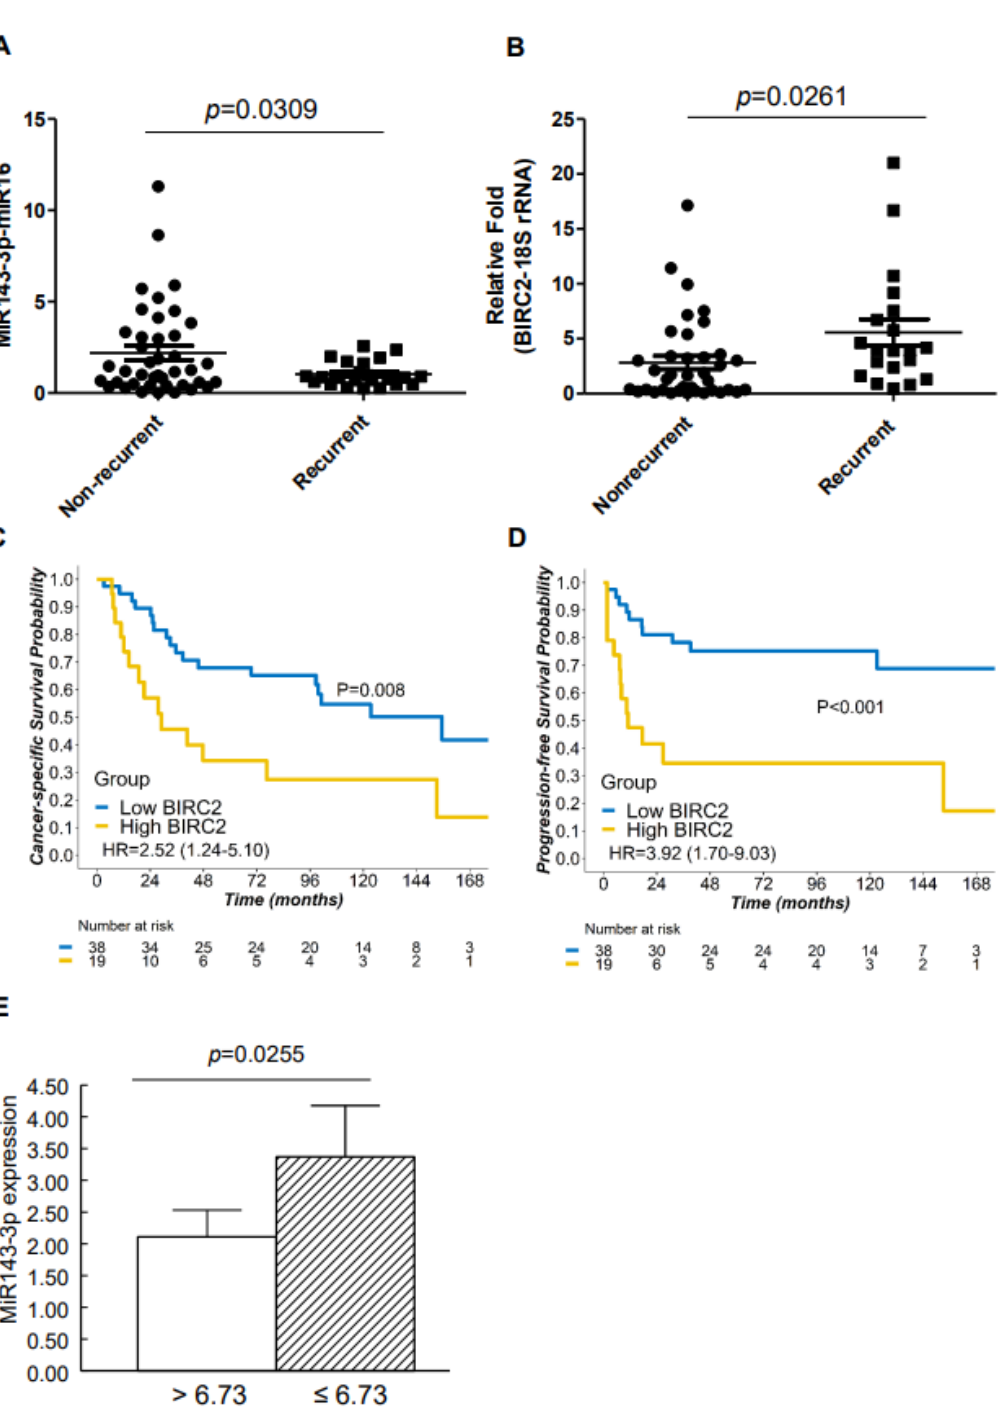
Figure 2. miR143-3p and BIRC2 mRNA expression in α 7-HPV-related SCC. ( A , B ) miR143-3p and BIRC2 were analyzed through real-time quantitative polymerase chain reaction (qPCR). ( C , D ) Kaplan–Meier plots of cancer-specific survival (CSS) and progression-free survival (PFS) in patients with cervical SCC. The optimal cutoff of expression for differentiating patients with cervical SCC who survived (n = 35) from those who did not (n = 22) was 3.734. The absolute number of patients at risk in each group at multiple time points is also reported. ( E ) The miR143-3p expression of the group with high BIRC2 expression (>6.73, n = 10) was significantly lower than that of the group with low BIRC2 expression (<6.73, n = 47).